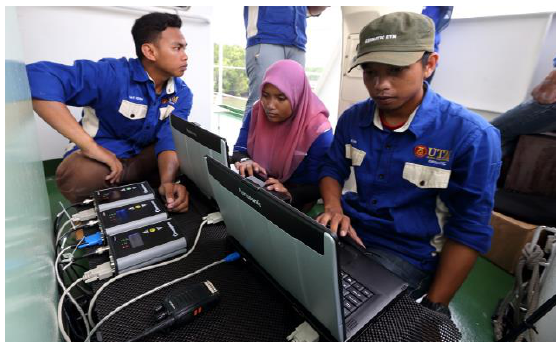
Figure 6. Operator monitor data recorded into master computer